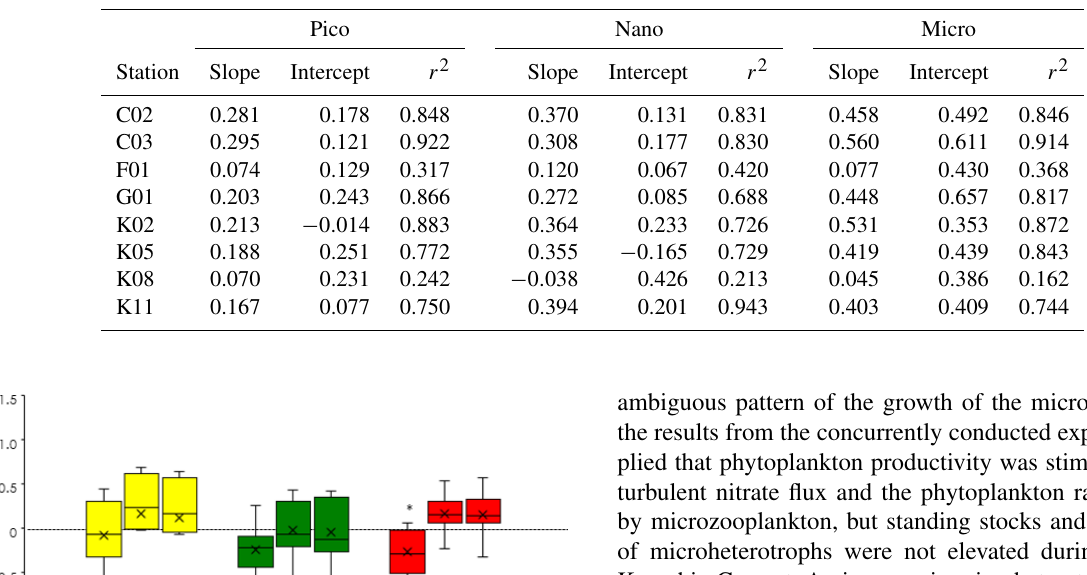
Table 4. Parameters derived from relationship of phytoplankton growth rates against logarithmically transformed concentrations of enriched nitrate in the gradient-enrichment experiments (EXP a ). Slope: sensitivity of phytoplankton growth rate to logarithmically transformed con- centrations of enriched nitrate. Intercept: growth potential at the low nitrate concentration. r 2 : coefficient of determination defined from the linear regression of growth rate of size-fractionated chlorophyll a concentrations against logarithmically transformed concentrations of